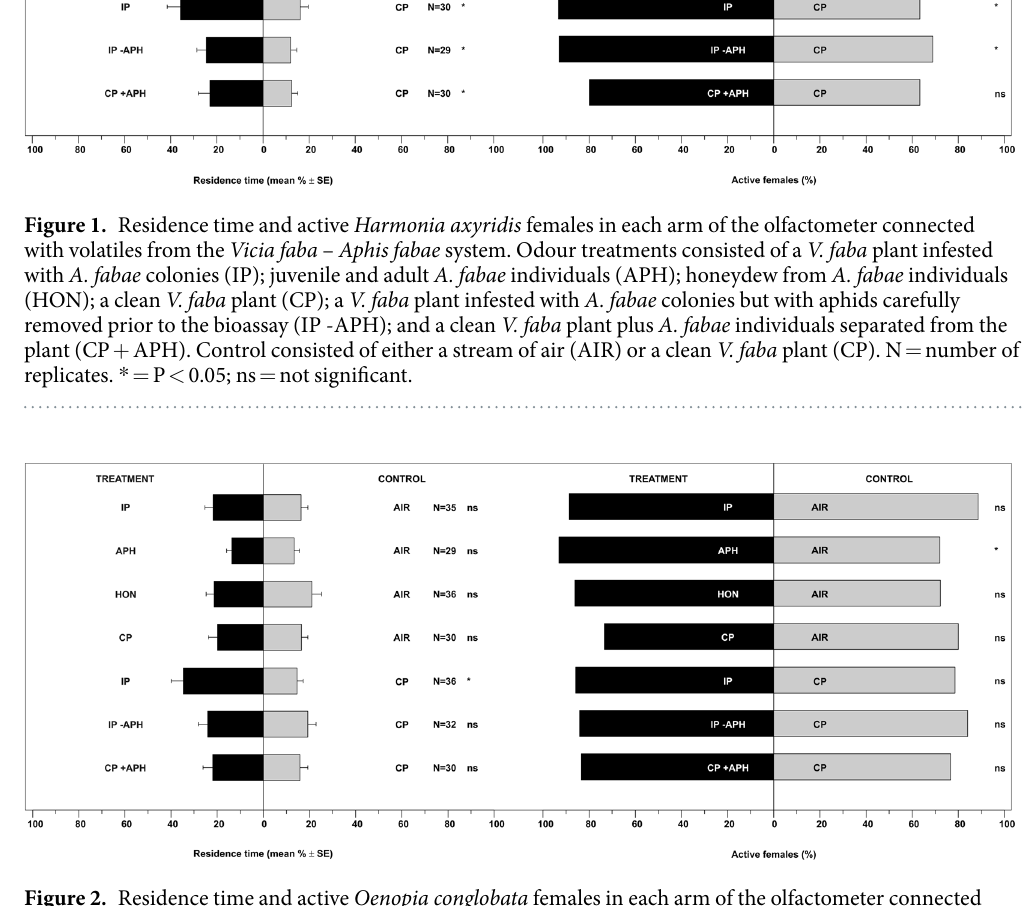
Figure 2. Residence time and active Oenopia conglobata females in each arm of the olfactometer connected with volatiles from the Vicia faba – Aphis fabae system. Abbreviations as in Fig. 1. N = number of replicates. * = P < 0.05; ns = not significant.